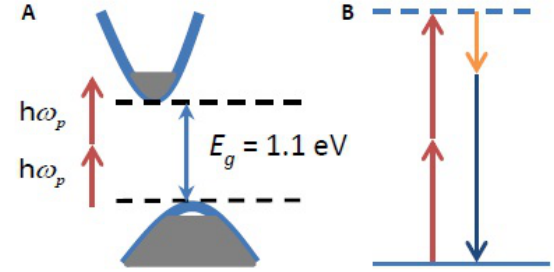
Fig. 1. (a) The two-photon absorption process: the combined energy of two photons generates a free carrier. (b) The degenerate four- wave mixing process in which a lower energy idler and high energy signal photon are created by the annihilation of two pump